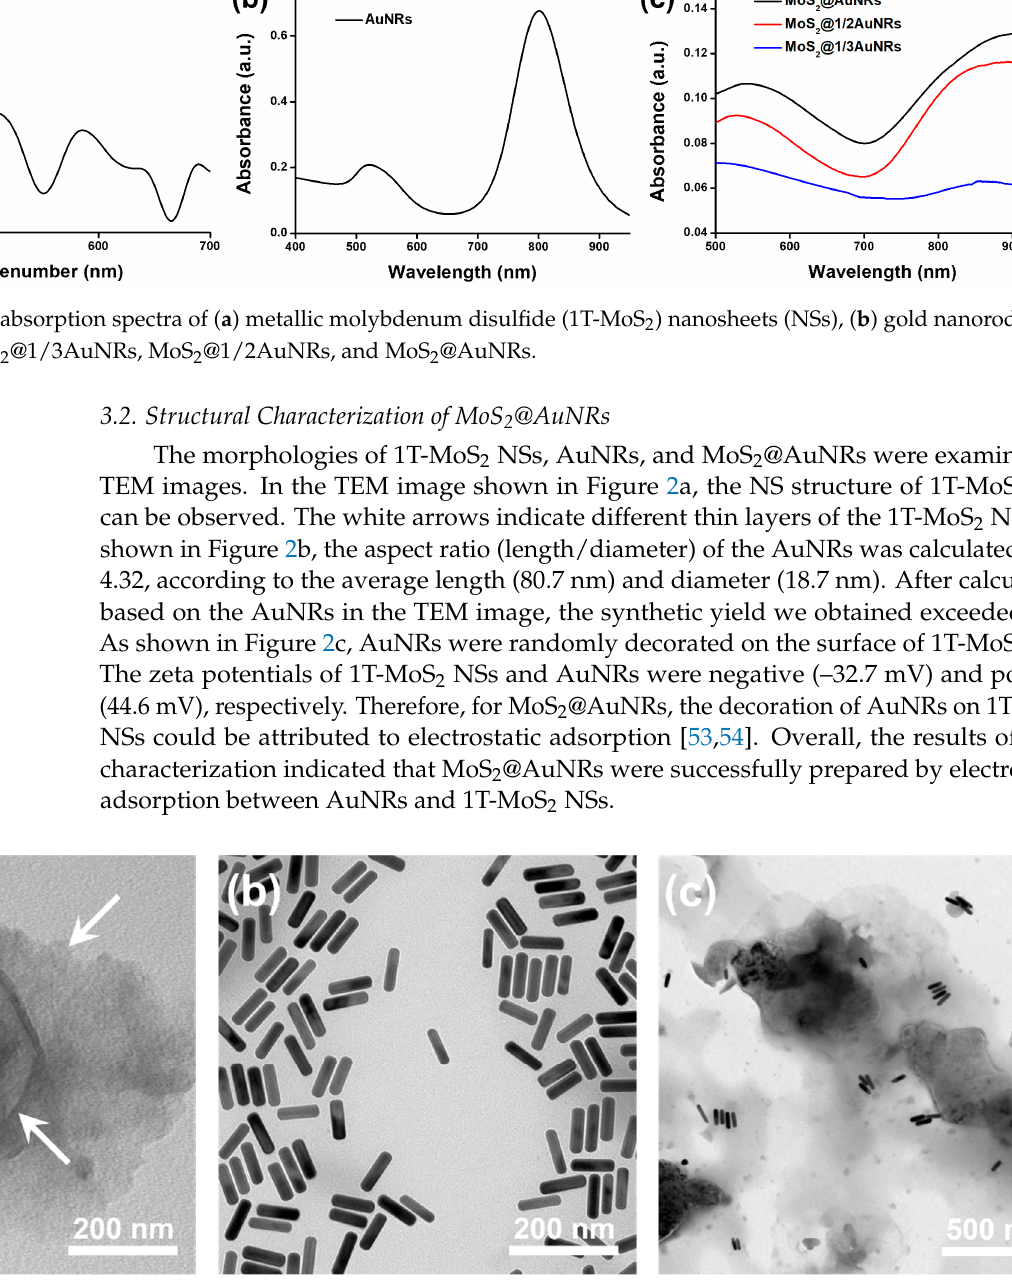
Figure 2. TEM images of ( a ) metallic molybdenum disulfide (1T-MoS 2 ) nanosheets (NSs), ( b ) gold nanorods (AuNRs), and ( c ) MoS 2 @AuNRs.